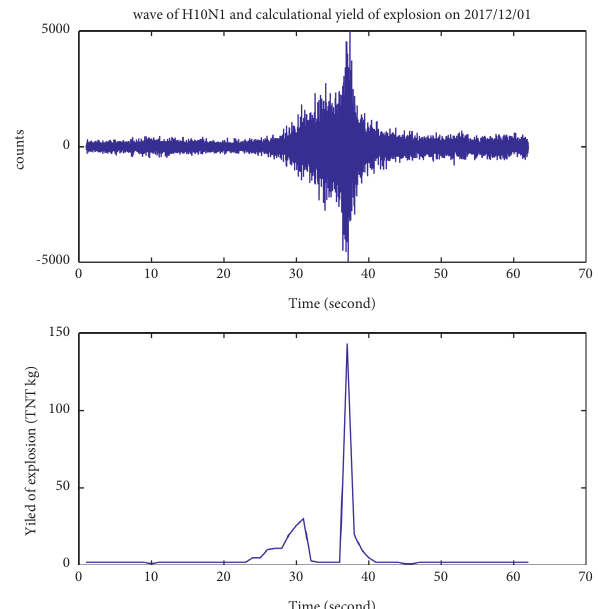
Figure 9: Equivalent estimation monitoring threshold trace in 90% probability of the H10N1